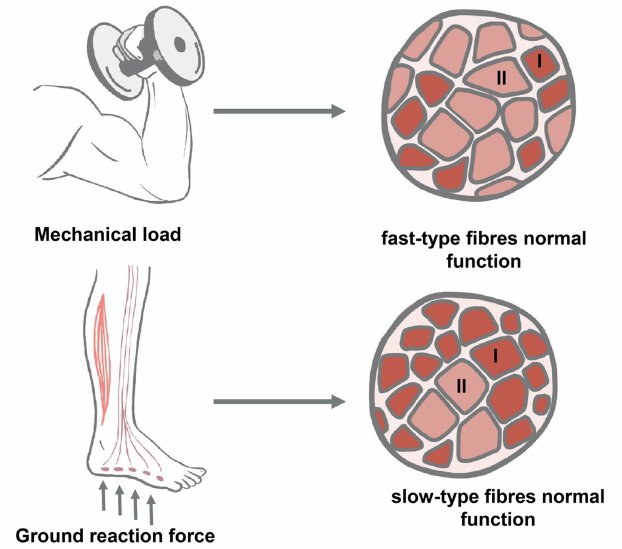
Figure 1. Involvement of mechanical load and ground reaction force into the regulation of slow-type (type I) or fast-type (type II) skeletal muscle